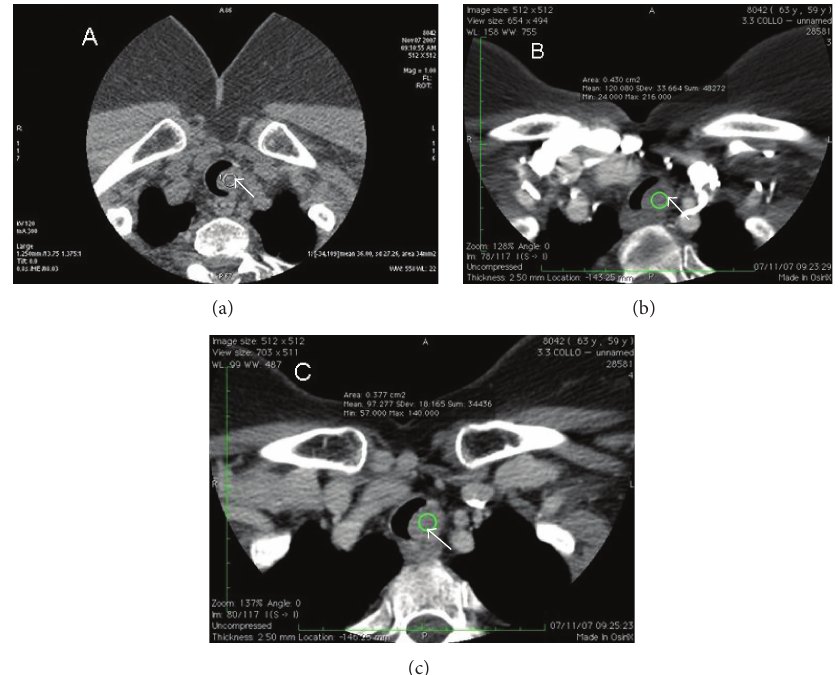
Figure 1: 64-year-old female with granular cell tumor of trachea. Axial multiphase contrast-enhanced CT (16-slice Multidetector CT, GE Medical Systems) demonstrating polypoid lesion (diameter 13mm) (white arrows), which presents smooth and well-defined margins and occupies the left side of the tracheal lumen. This mass does not present infiltrative signs suggestive of malignancy. The lesion shows elevated contrast enhancement in arterial phase and a modest release of contrast in venous phase; this behaviour is the tomographic expression of the rich vascularity of this kind of tumor. (a) Basal: 36 HU. (b) Arterial phase: 120HU. (c) Venous phase: 100HU.